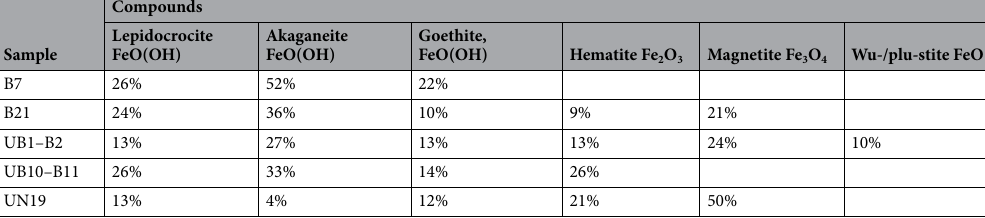
Table 2. Analysis of XRD patterns for the investigated